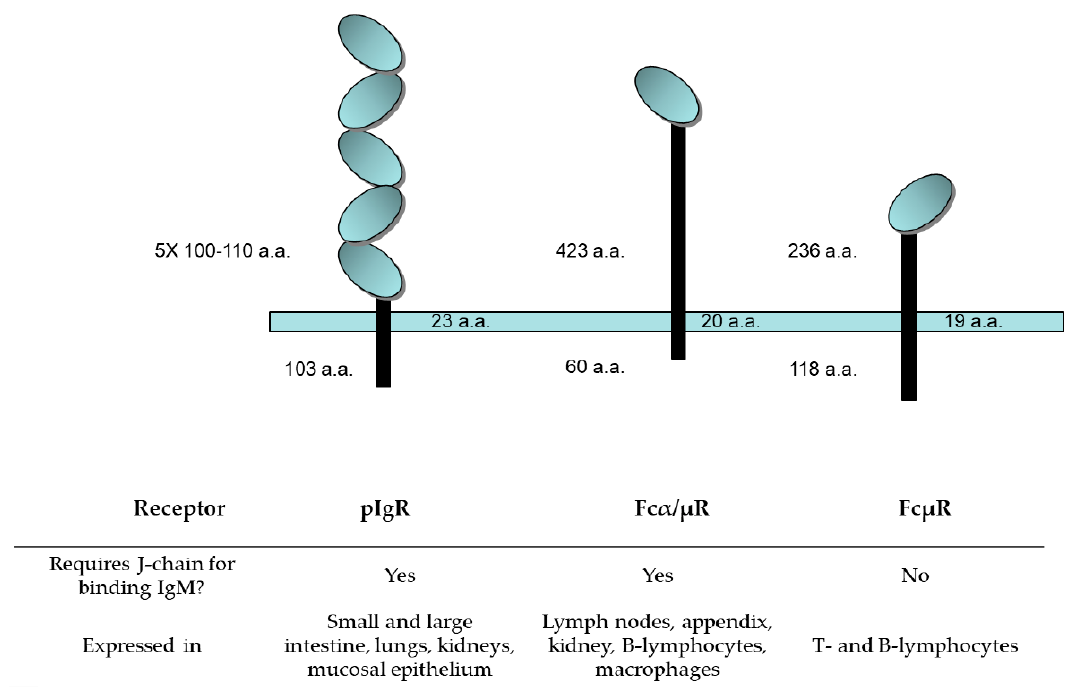
Figure 8. Schematic diagram of receptors known to bind IgM. IgMs bind at least three di ff erent receptors from those that bind IgG. The oval domains of each receptor indicate immunoglobulin fold-like regions. Their sizes and tissue distribution are depicted above.